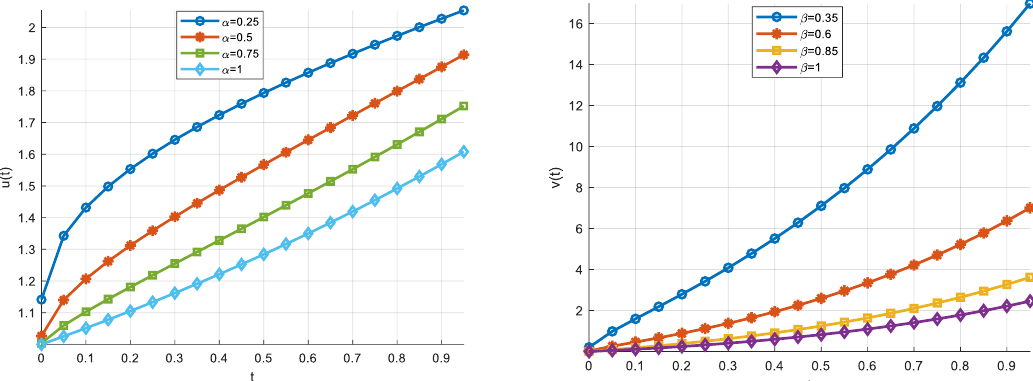
( ) v t ( ) u t and for several fractional orders for Example 3 (